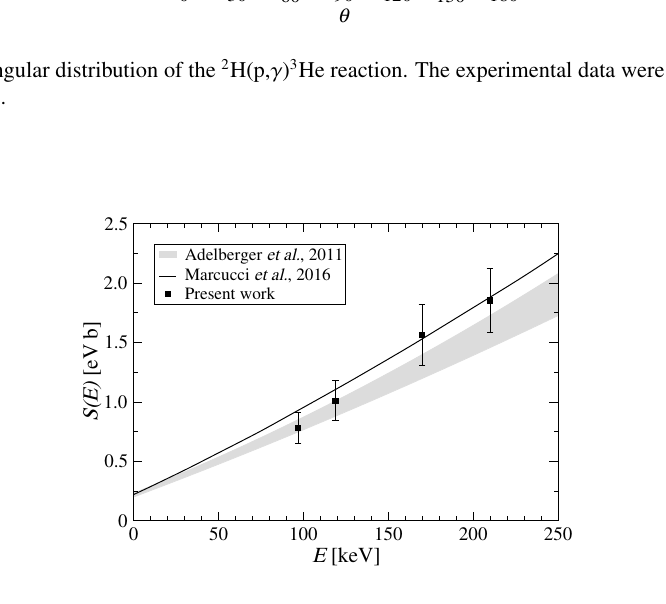
Figure 3. Astrophysical S-factor for the 2 H(p, γ ) 3 He reaction in the energy range of interest for BBN. Error bars show statistical uncertainty